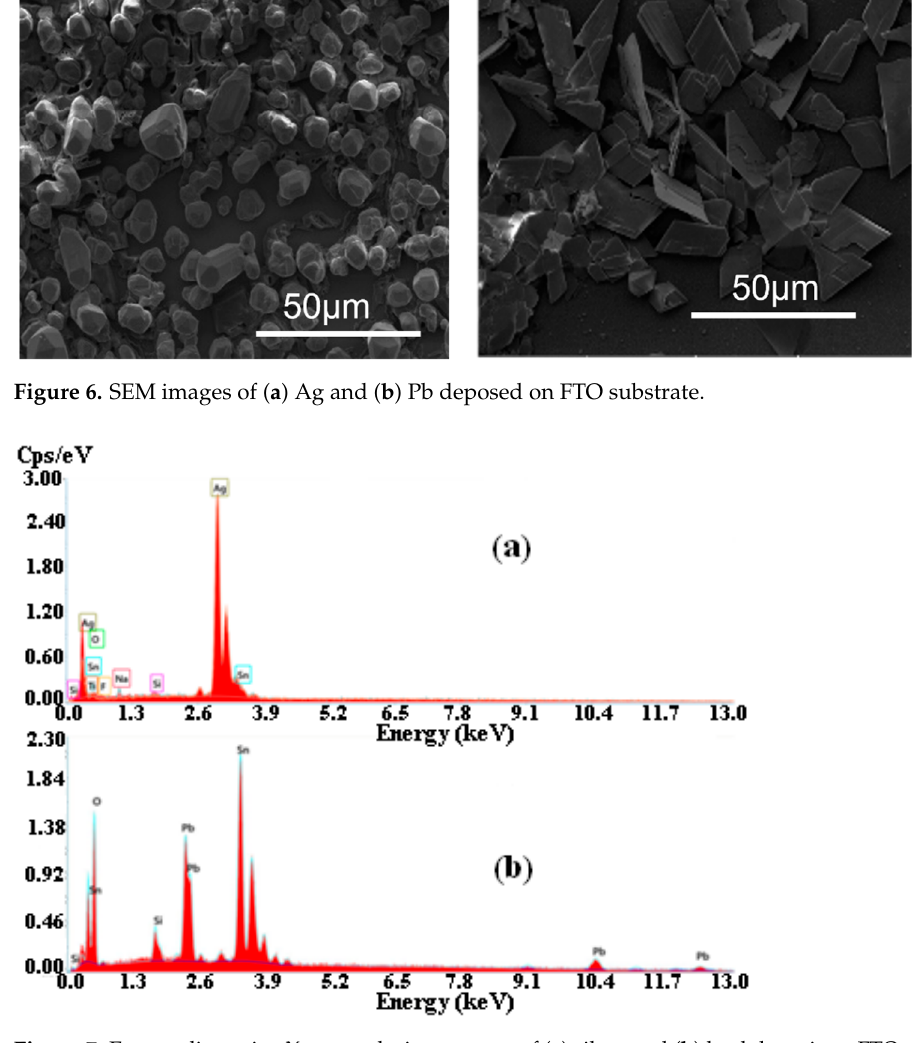
Figure 7. Energy dispersive X-ray analysis spectrum of ( a ) silver and ( b ) lead deposit on FTO sub ‐ strate.